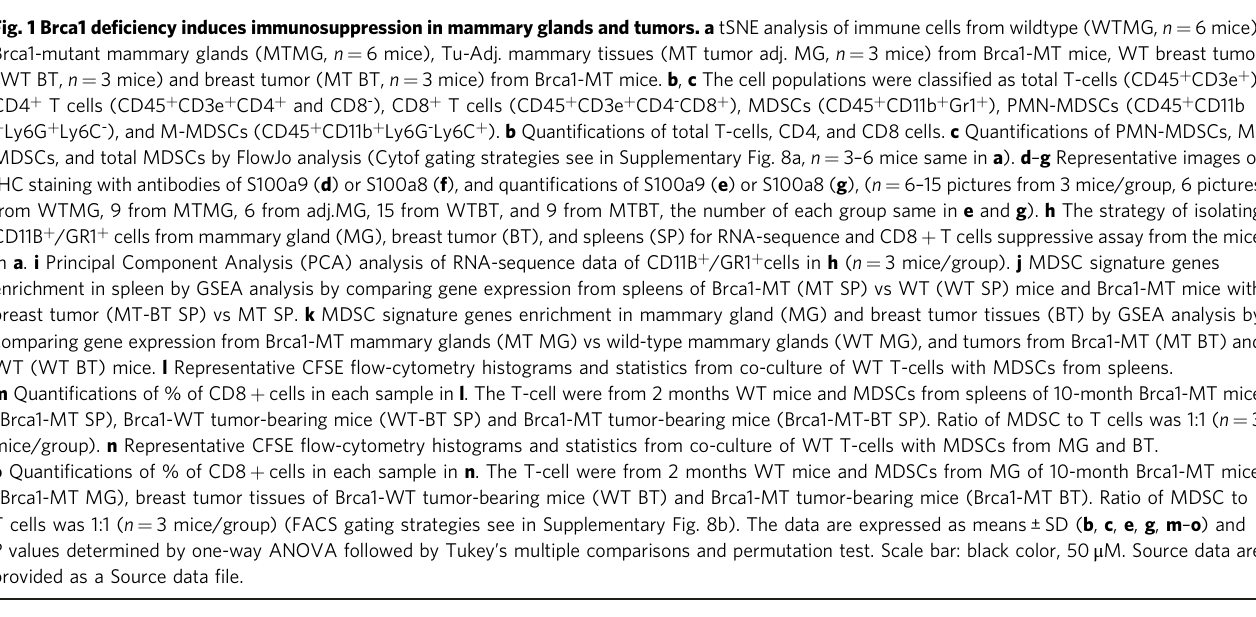
Fig. 1 Brca1 de fi ciency induces immunosuppression in mammary glands and tumors. a tSNE analysis of immune cells from wildtype (WTMG, n = 6 mice), Brca1-mutant mammary glands (MTMG, n = 6 mice), Tu-Adj. mammary tissues (MT tumor adj. MG, n = 3 mice) from Brca1-MT mice, WT breast tumor (WT BT, n = 3 mice) and breast tumor (MT BT, n = 3 mice) from Brca1-MT mice. b , c The cell populations were classi fi ed as total T-cells (CD45 + CD3e + ), CD4 + T cells (CD45 + CD3e + CD4 + and CD8 - ), CD8 + T cells (CD45 + CD3e + CD4 - CD8 + ), MDSCs (CD45 + CD11b + Gr1 + ), PMN-MDSCs (CD45 + CD11b + Ly6G + Ly6C - ), and M-MDSCs (CD45 + CD11b + Ly6G - Ly6C + ). b Quanti fi cations of total T-cells, CD4, and CD8 cells. c Quanti fi cations of PMN-MDSCs,